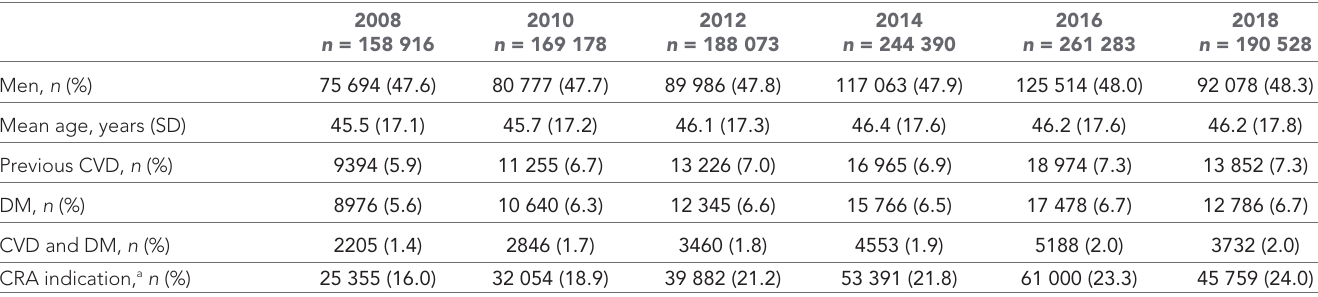
Table 1 Baseline characteristics of studied population